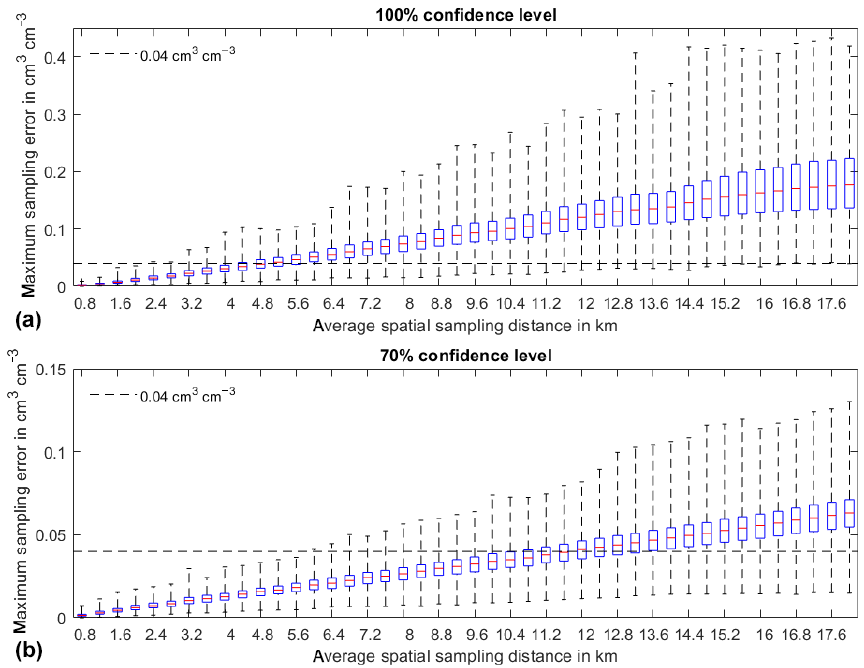
Figure 3. Box–whisker plots, with the median in red, 25th and 75th percentiles as bounds of the box, and whiskers encompassing all values of the maximum sampling errors for the 320 satellite footprints of the arithmetic mean soil moisture estimated for all network configurations observing twice a day over 1 year at the given sampling distances (abscissa). Panel (a) shows the absolute maximum error, while (b) displays the results for the 70th percentile of the sampling error distribution at each satellite footprint. The horizontal dashed line is the 0.04cm 3 cm − 3 retrieval error anticipated for SMOS and